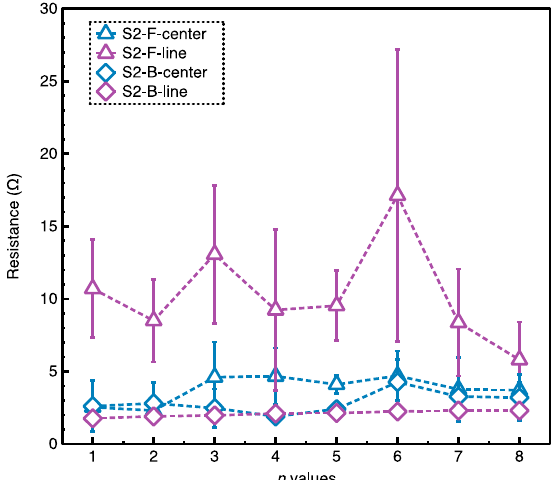
Figure 10. The change of resistance with distances for the silver-incorporated Song Brocade fabric (the sample S2).